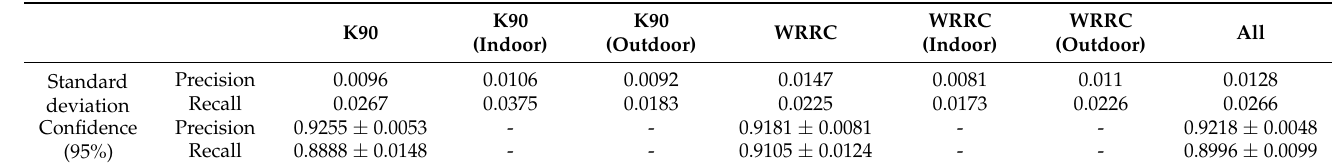
Table 4. Precision and recall of various algorithms.